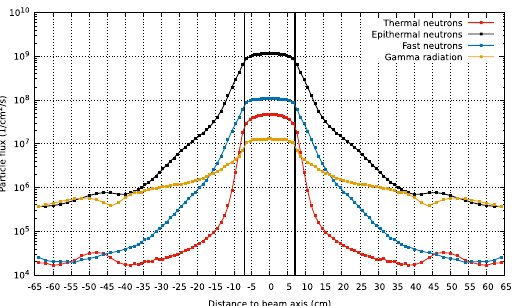
Figure 7. Lateral flux beam profile at the BSA aperture. Beam collimation and contamination suppression are